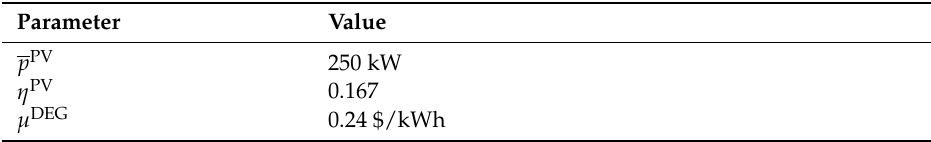
Table 3. PV system data [26].